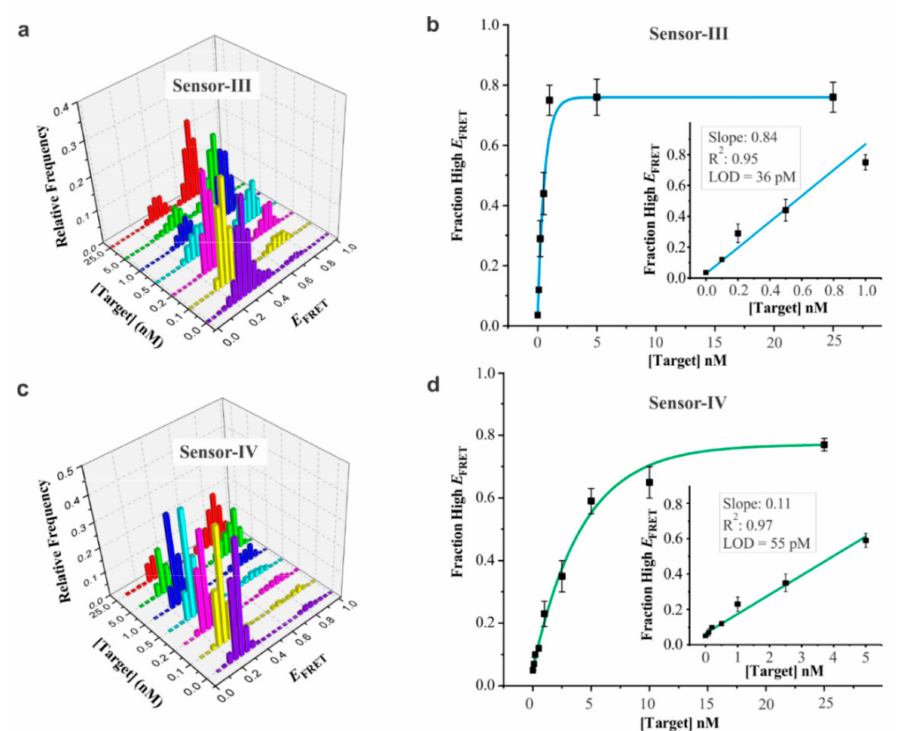
Figure 4. Analytical sensitivity of DNA sensors. ( a ) smFRET histograms of sensor-III for di ff erent concentrations of the target (0, 0.1, 0.2, 0.5, 1, 5, and 25 nM). The 0 nM data represent control experiment in the absence of the target. ( b ) Calibration curve of sensor-III depicting fraction of high- E FRET population against target concentration. High- E FRET population was determined from the two-peak Gaussian fitting of the histograms in Figure 3a. Inset displays the linear region of the full titration curve. R 2 value obtained from linear fitting was 0.95, and the limit of detection (LOD) was 36 pM, as determined using the equation, LOD = (3 × SD blank ) / slope, where SD blank represents the standard deviation of high-E FRET fraction in the absence of the target. ( c ) smFRET histograms of sensor-IV for di ff erent concentrations of the target. ( d ) Calibration curve of sensor-IV. Inset depicts the linear fitting region. R 2 value from linear fit was 0.97, and the detection limit was calculated to be 55 pM. Error bars in ( b ) and ( d ) represent the standard deviations (SD), n = 3. Each E FRET histogram was prepared from 90–110